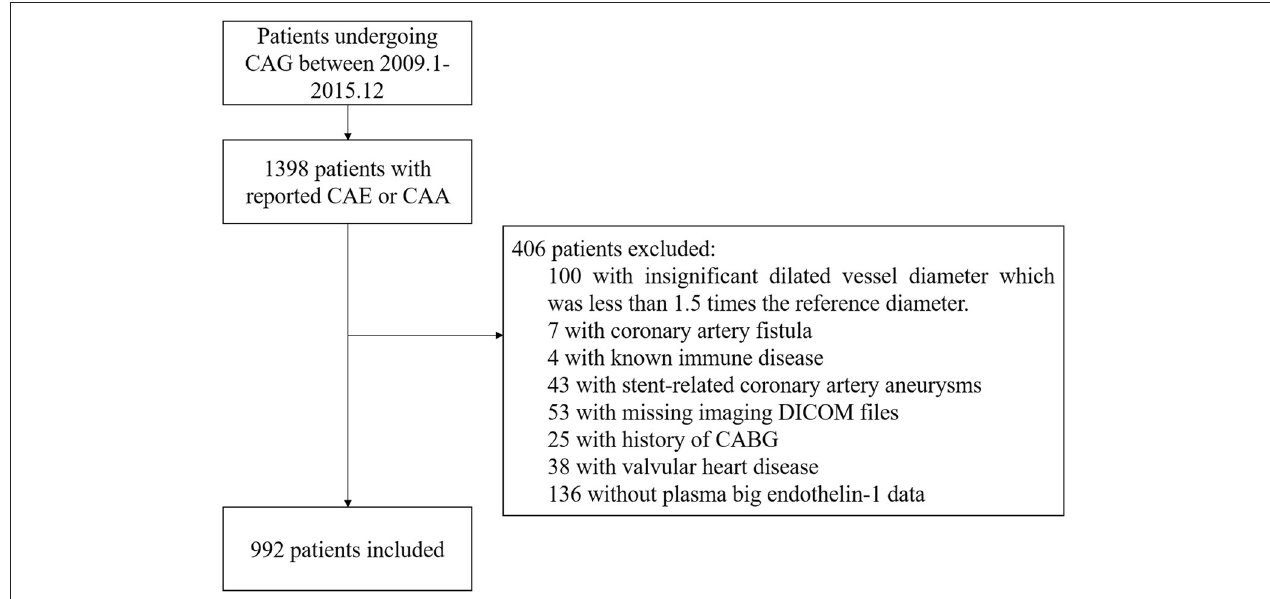
FIGURE 1 | Flowchart of the study subjects. CAA, coronary artery aneurysm; CAE, coronary artery ectasia; CAG, coronary artery